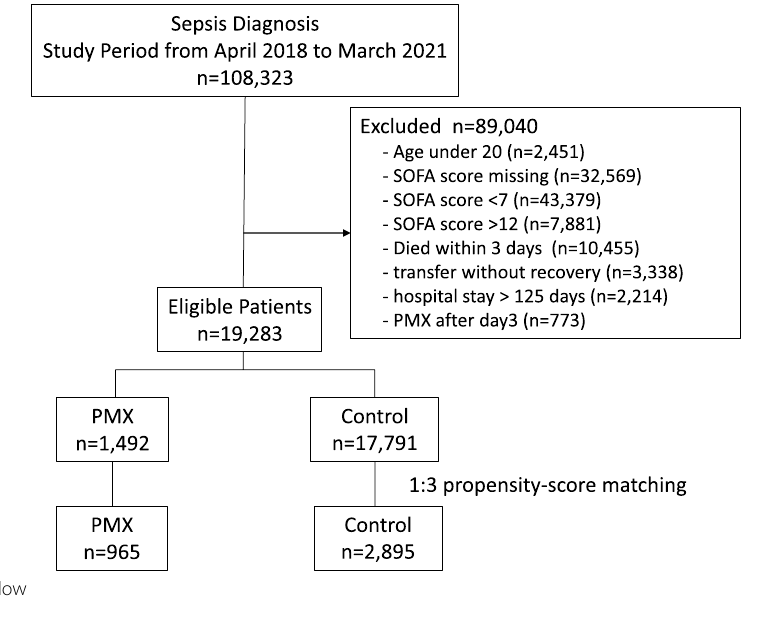
Fig. 1 Patient selection flow